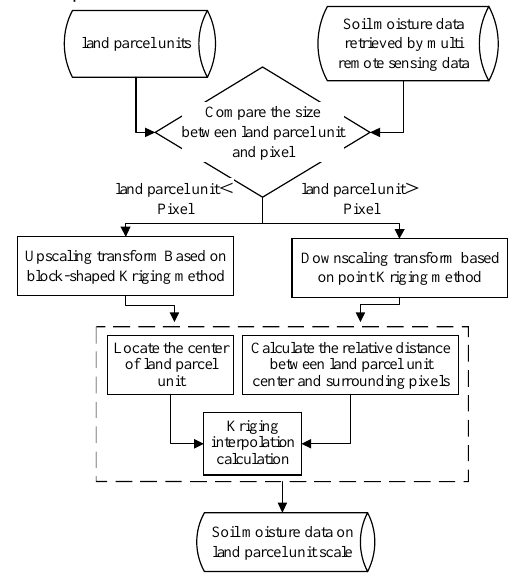
Figure 3. Land-based scale transformation process of soil moisture